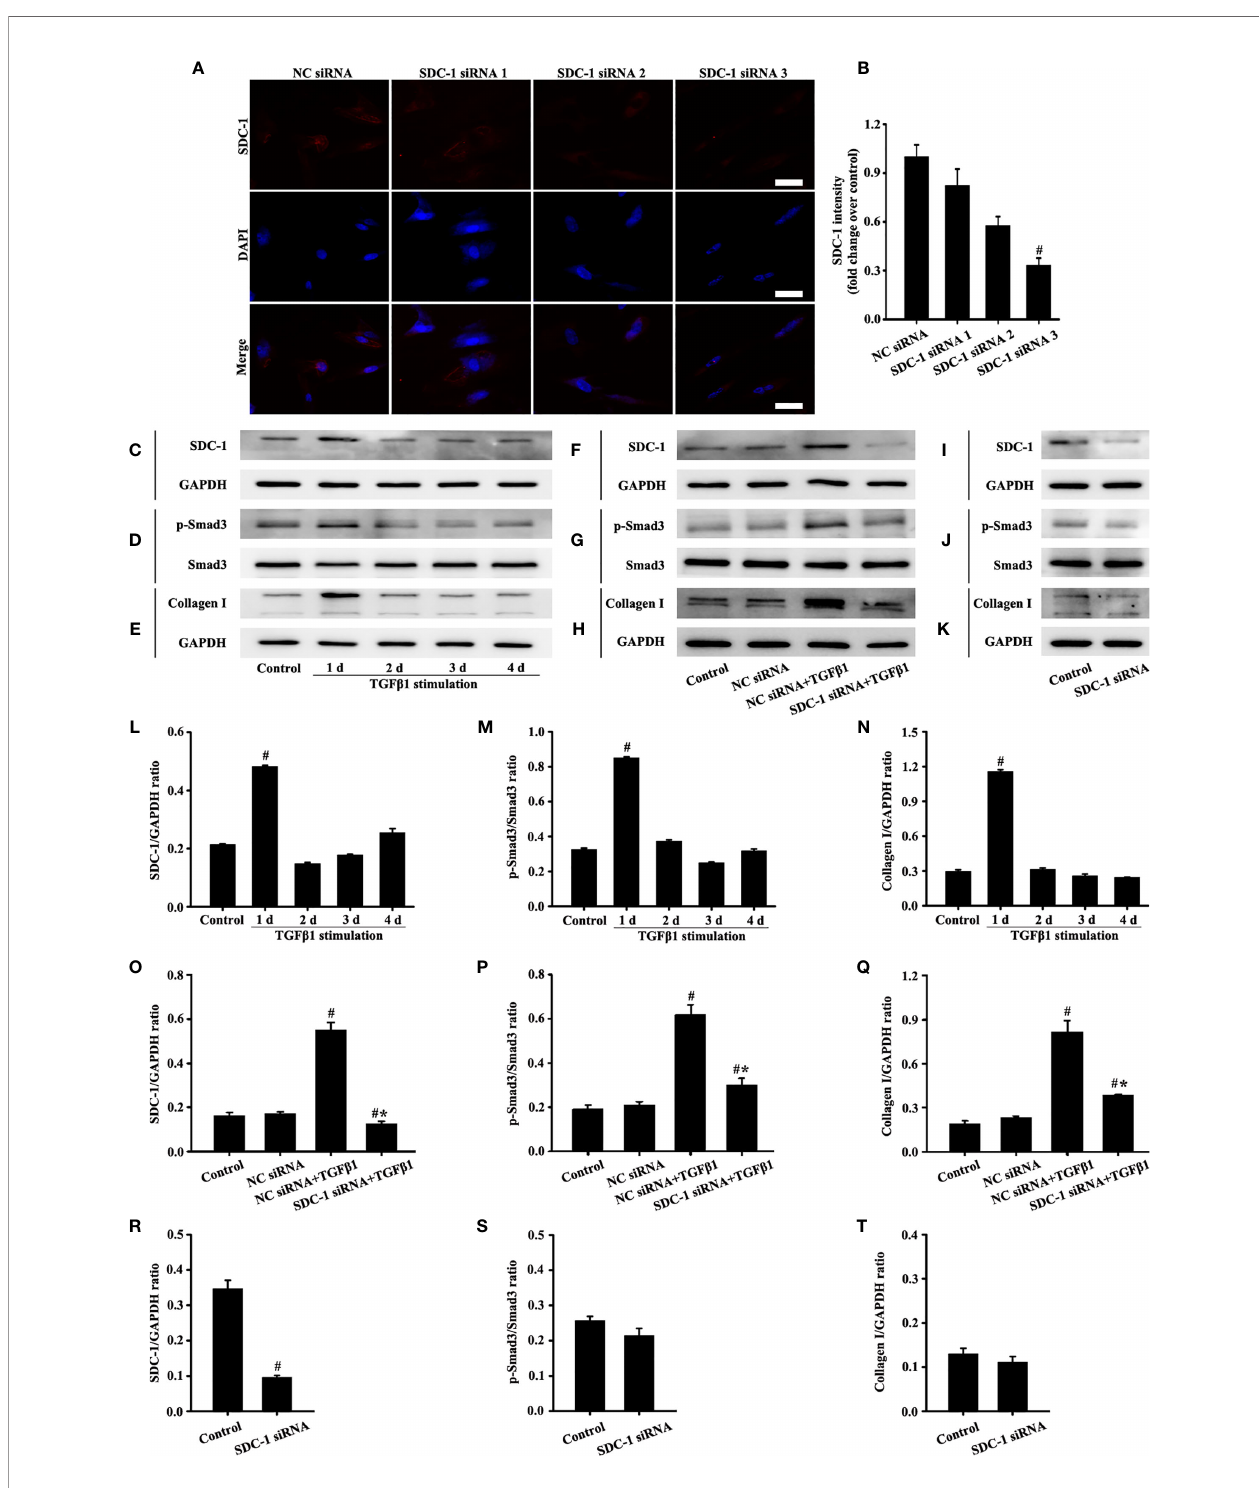
FIGURE 6 | Effects of SDC-1 siRNA on HLF-1 cells were detected. Deletion effects of SDC-1 siRNA 1, 2, or 3 on SDC-1 expression (A) were observed by immuno fl uorescence. Changes in levels of SDC-1 (C) , p-Smad3 (D) , and collagen I (E) under TGF b 1 stimulation were detected by Western blot. Effect of SDC-1 siRNA 3 on the levels of SDC-1 (F , I) , p-Smad3 (G , J) , and collagen I (H , K) were detected by Western blot. (B) SDC-1 immuno fl uorescence intensity analysis of (A). (L – T) Protein intensity analysis of (C – K) , respectively. Data are shown as the means ± SD of three independent experiments. # p < 0.05 versus the control group. # *p < 0.05 versus the NC siRNA+ TGF b 1